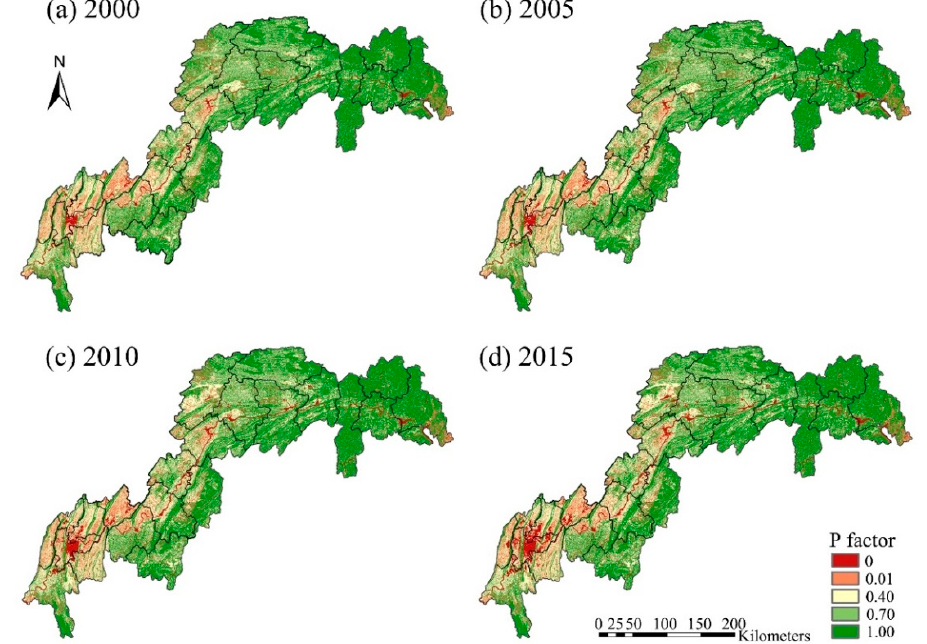
Figure 7. Estimated changes in the spatial pattern of support practice, P factor (2000–2015).